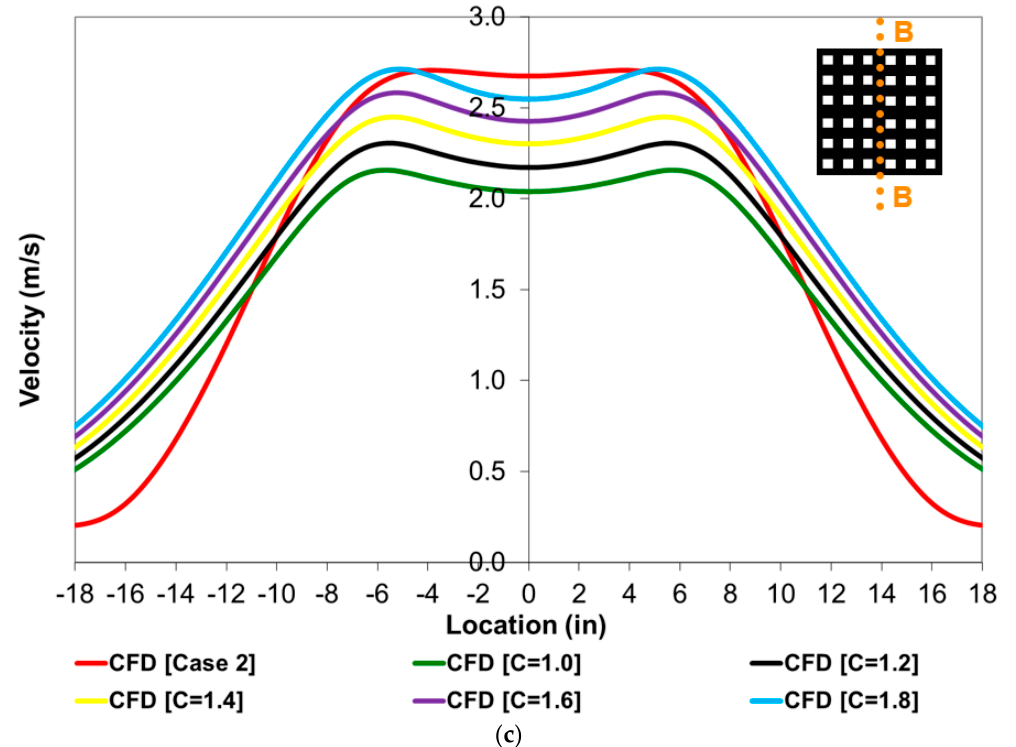
Figure 10. ( a ) Velocity profiles at 1 ft height along line B-B for Case 2 and momentum source model results at different C values. ( b ) Velocity profiles at 2 ft height along line B-B for Case 2 and momentum source model results at different C values. ( c ) Velocity profiles at 3 ft height along line B-B for Case 2 and momentum source model results at different C values.